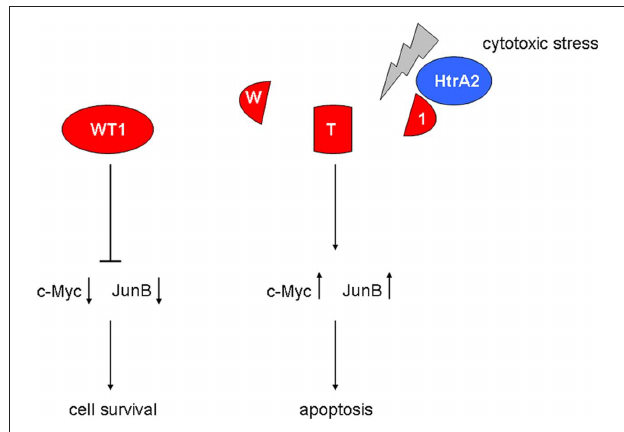
FIgure 4 | Proposed roles of WT1 and hypoxia-inducible factor HIF-2 α in KRAS -driven tumor formation. The prooncogenic effects of WT1 are closely linked to KRAS signaling, and inactivation of WT1 inhibits KRAS -dependent tumor formation. Deletion of HIF-2 α promotes KRAS -driven tumorigenesis through down-regulation of the tumor suppressor Scgba1.